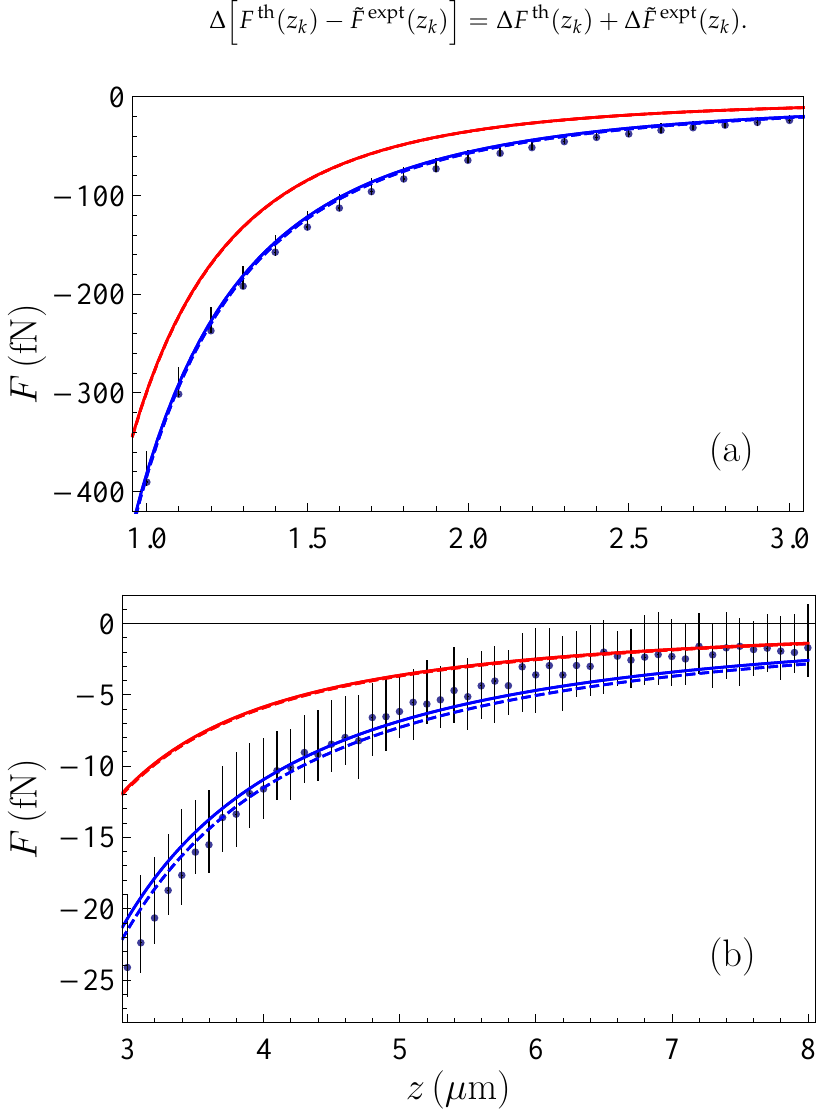
Figure 15. The theoretical Casimir forces computed exactly using extrapolations of the optical data by the Drude and the plasma models are shown as functions of separation by the red and blue solid lines, respectively, over the region of separations ( a ) from 1.0 to 3.0 µ m and ( b ) from 3.0 to 8.0 µ m. Similar results obtained using the proximity force approximation are shown by the red and blue dashed lines. The experimental Casimir forces are indicated as